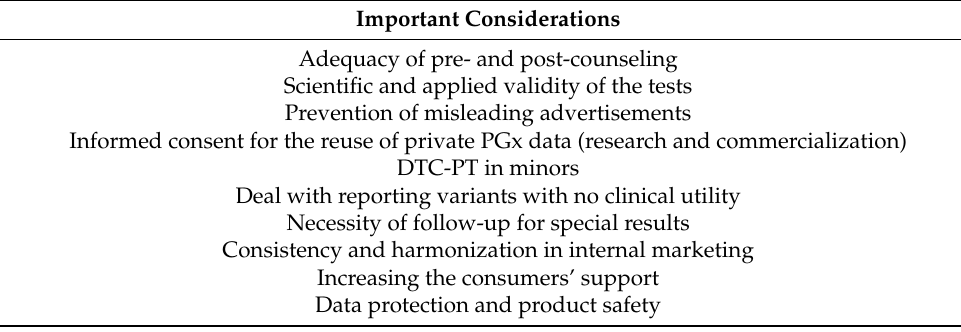
Table 3. Ethical and legal considerations for companies offering